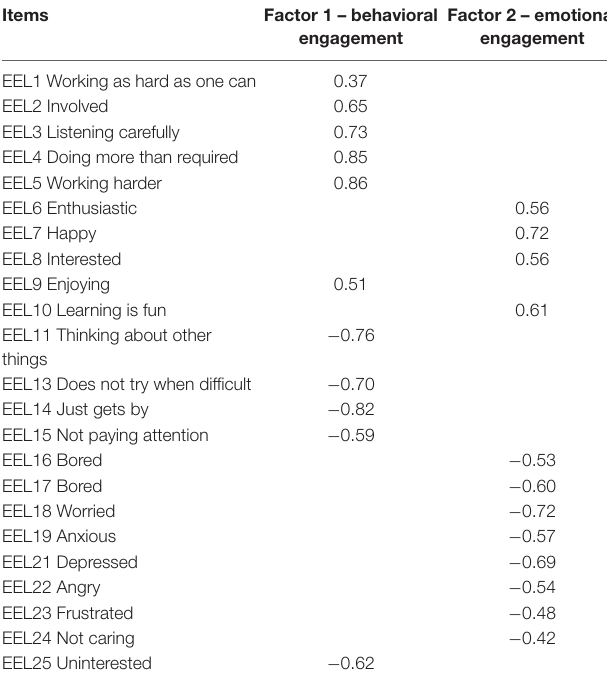
TABLE 1 | Pattern matrix of factor loadings in